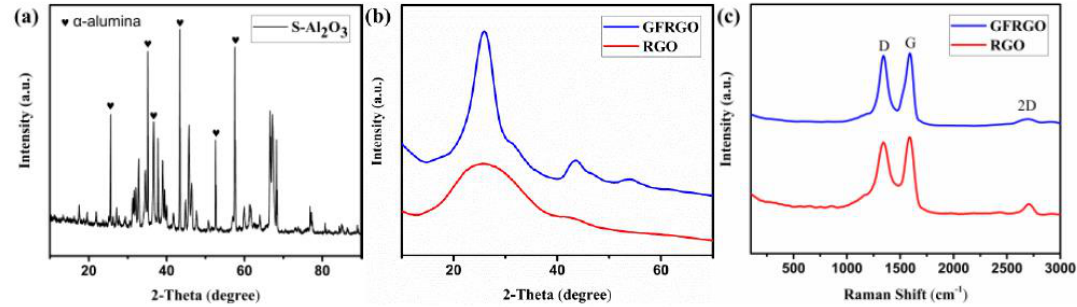
Figure 3. XRD patterns of ( a ) S-Al 2 O 3 , ( b ) RGO and GFGRO; ( c ) Raman spectra of RGO and GFGRO.